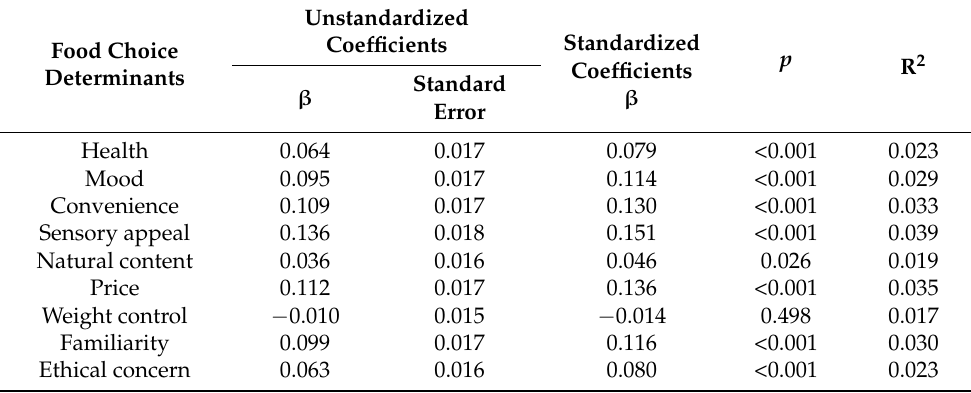
Table 6. Analysis of association between food choice determinants assessed by Food Choice Question- naire (FCQ) and dairy preference assessed by Food Preference Questionnaire (FPQ) (model adjusted for sex and age) within the population of the second phase of the Polish Adolescents’ COVID-19 Experience (PLACE-19) Study ( n =